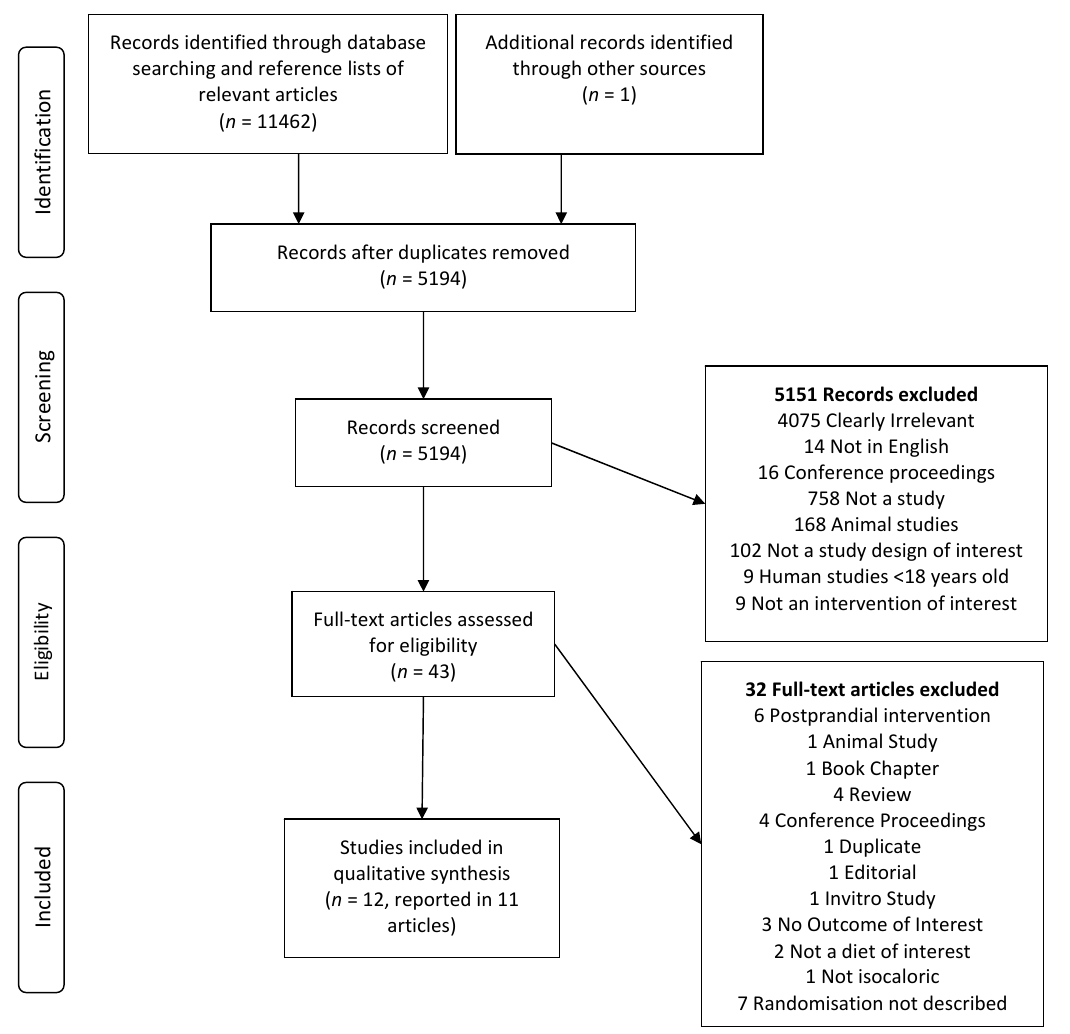
Figure 1. PRISMA Flow diagram of search results, screening and included